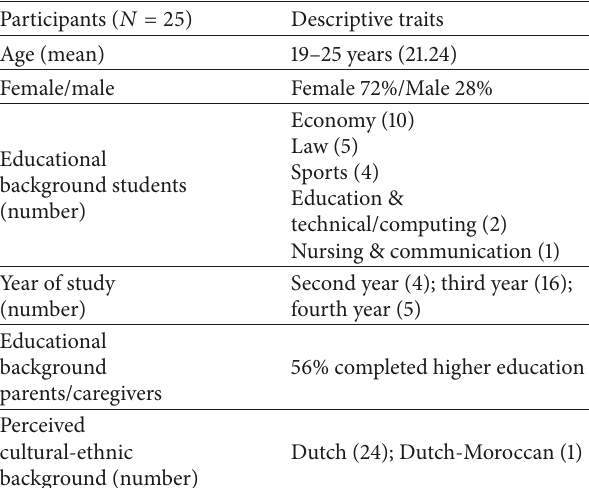
Table 2: Characteristics of the